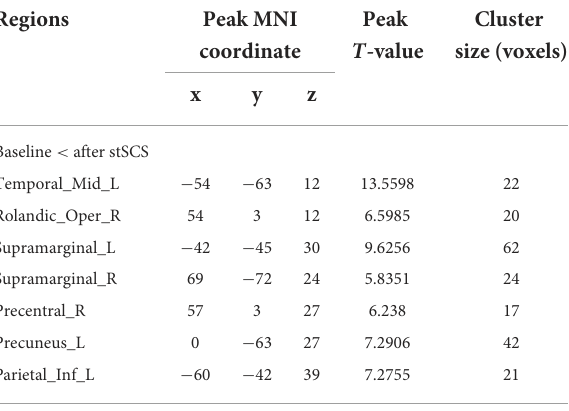
TABLE 3 Clusters of different DC values between baseline and after